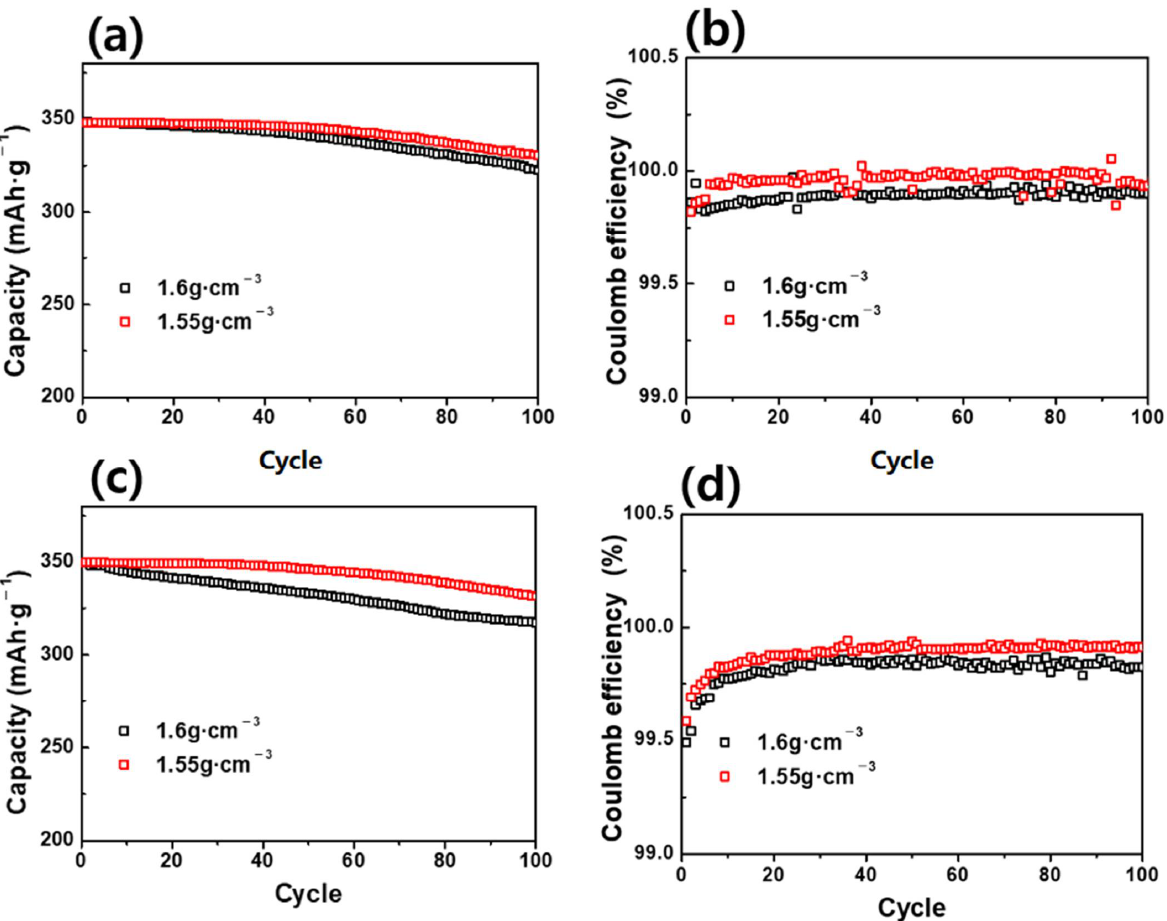
Figure 4. Comparison of cycling performance behavior of artificial graphite (AG) electrodes with different electrode Table 1. Tap density of MNG and AG, and sheet resistance of 、、 MNG and AG electrodes with densities at ( a , b ) 30 ◦ C and ( c , d ) 45 ◦ different electrode densities.